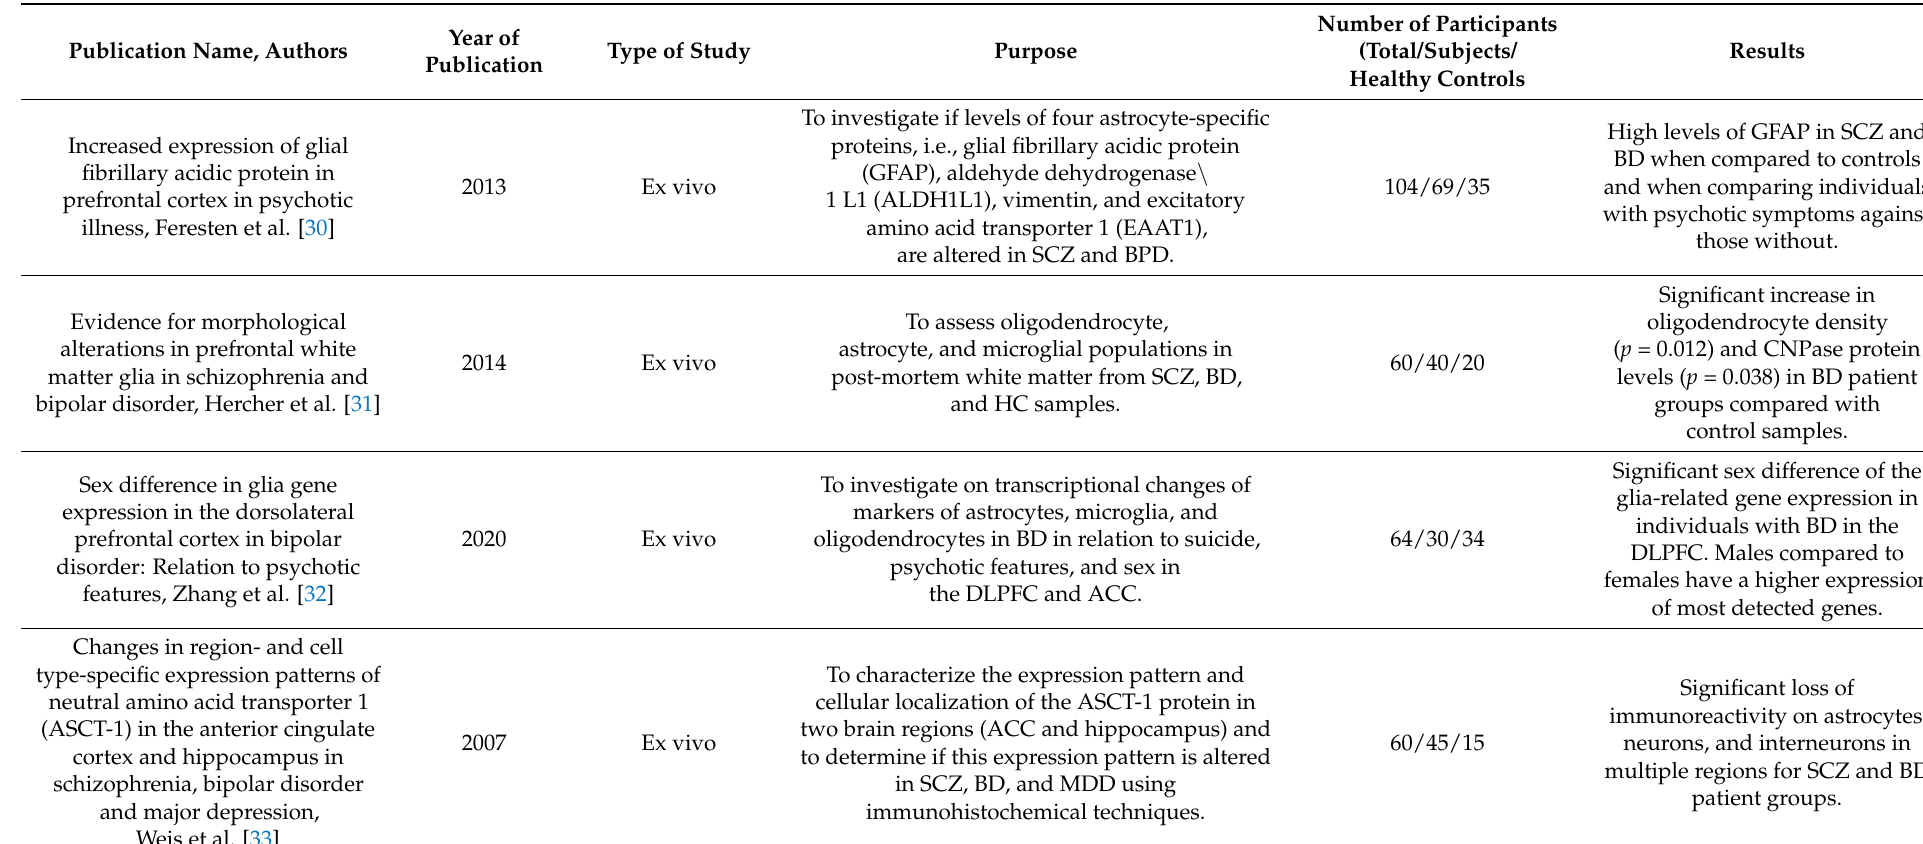
Table 2. Summary of ex vivo publications included in the scoping review. Includes publication name, authors, year of publication, type of study, purpose,